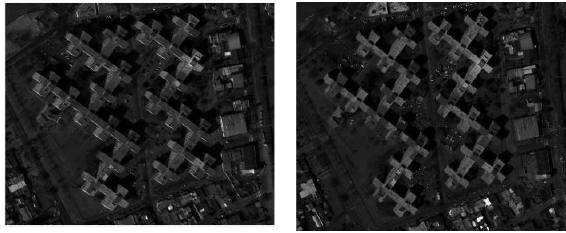
Figure 1: The epipolar image from WV III images. The left image captured on 1 September 2015 and the right image captured on 3 October 2015.